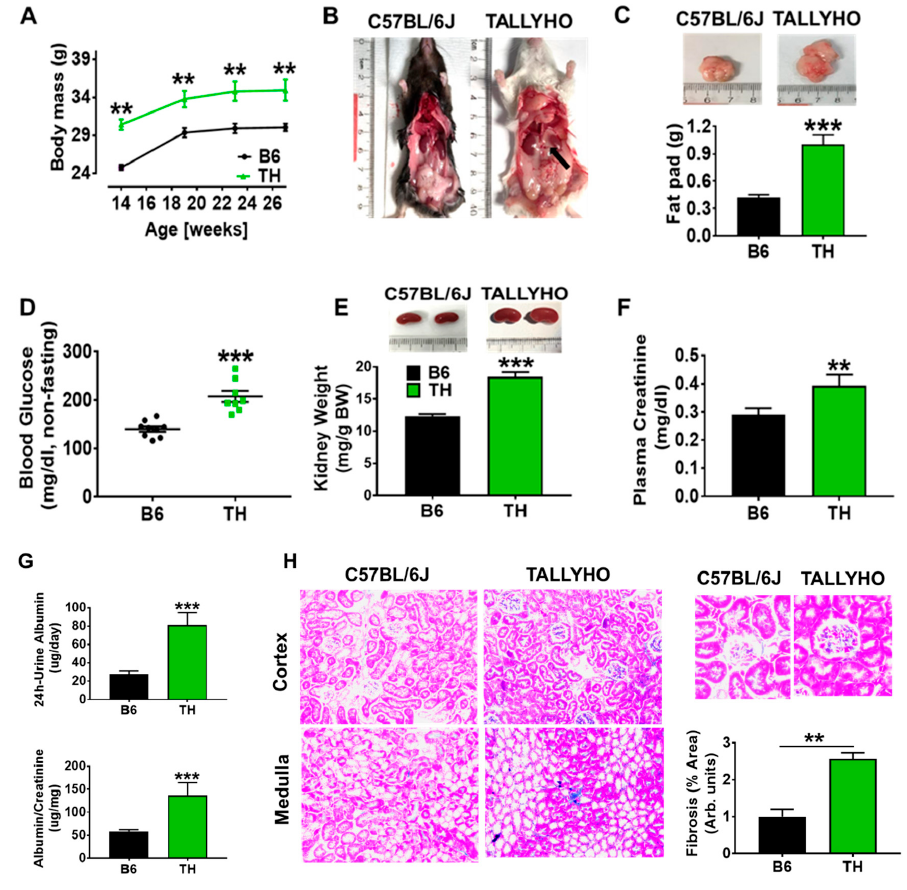
Figure 1 . TALLYHO/JngJ (TH) mice on normal chow exhibit the risk-factor clustering and kidney dysfunction associated with obesity and metabolic disorders. TH and C57BL/6J (B6) mice were monitored for a time period of 13 weeks, starting at the age of 14 weeks. ( A ) Body mass ( n = 8–9). ( B ) Abdominal photograph of representative 23–27 week old male mice (arrow showed the renal sinus fat). ( C ) Fat-pad mass ( n = 7–8). ( D ) Non-fasting blood glucose levels ( n = 8–9). ( E ) Kidney mass ( n = 9–10). ( F ) Plasma creatinine ( n = 7–10). ( G ) 24 h urinary albumin excretion rate and urinary albumin to creatinine ratio ( n = 7–9). ( H ) Masson’s trichrome staining of kidneys. Representative